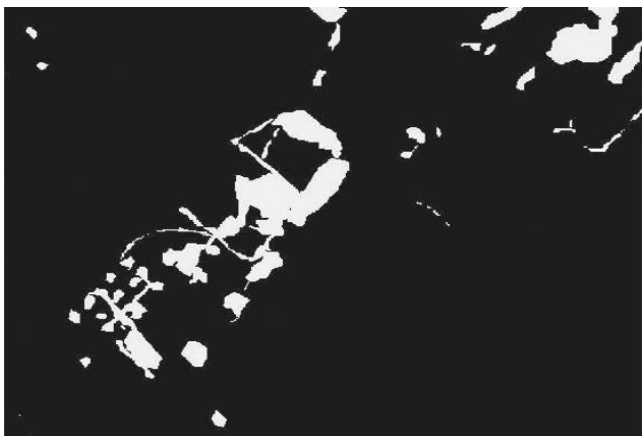
Figure 14. Reference sample image.